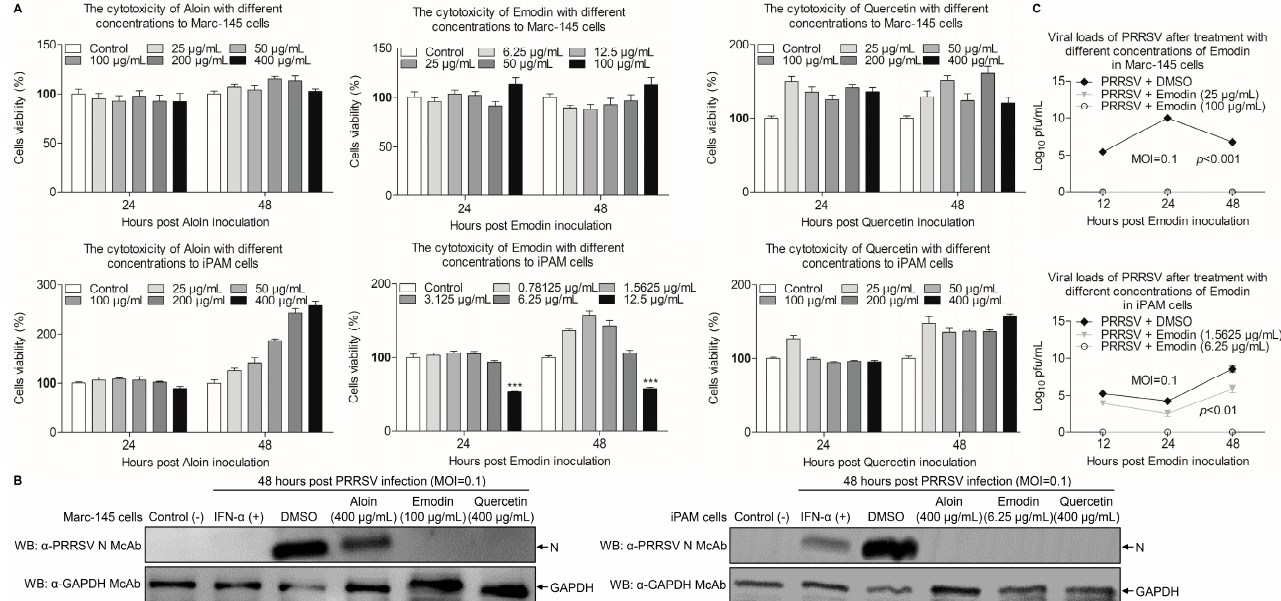
Figure 3. Emodin inhibits PRRSV replication in vitro . ( A ) The cytotoxicity of Aloin, Emodin and Quercetin to Marc-145 and iPAM cells in vitro . Marc-145 or iPAM cells were cultured with various concentrations of Aloin (25–400 μ g/mL), Emodin (0.78125–100 μ g/mL) and Quercetin (25–400 μ g/mL) or the control 0.1% DMSO for 24 h and 48 h prior to the CCK-